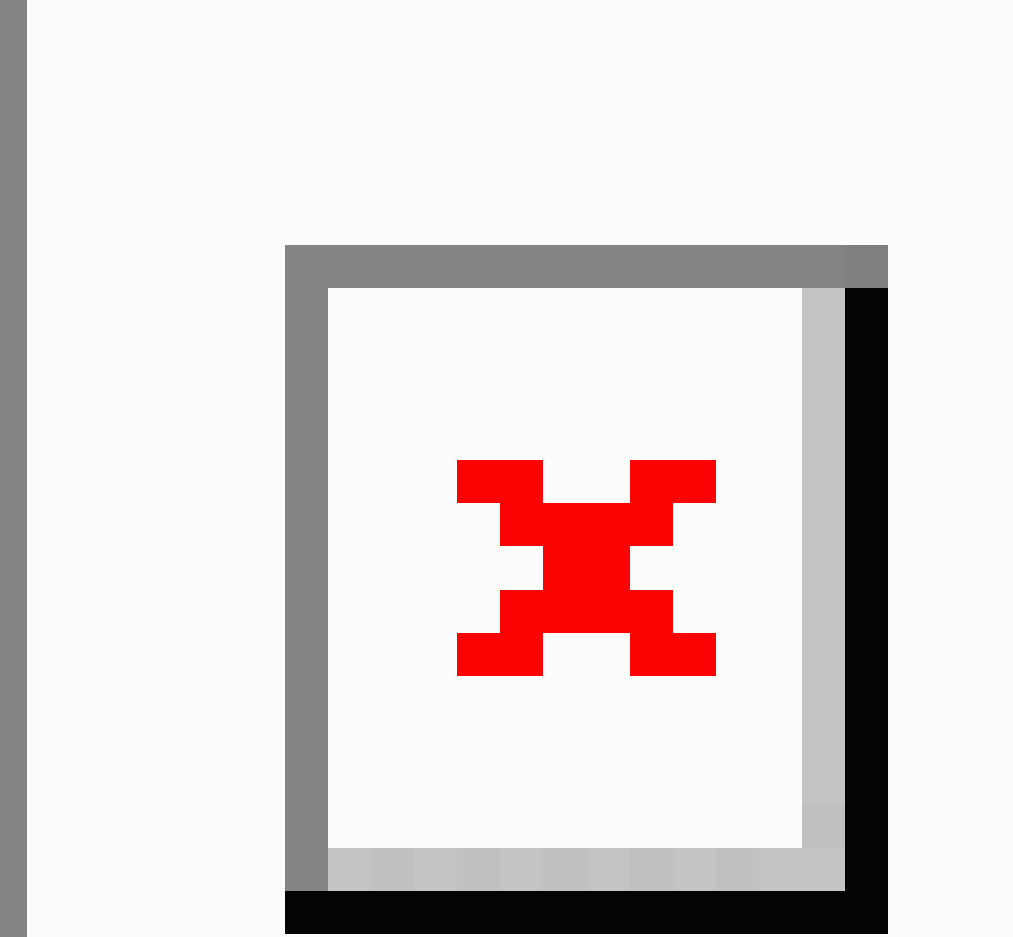
Figure 8. All scenarios scored maximum for ease of completion (blue) apart from the fall alarm 1 which caused slight confusion. Time taken (red) was not considered a major issue for any of the scenarios, with the connection routine not scoring maximum due to the nature of the syncing process, whereas the unfamiliarity with typing caused some users to mark down the login sequence. There was some confusion with the reset and login sequences in the user